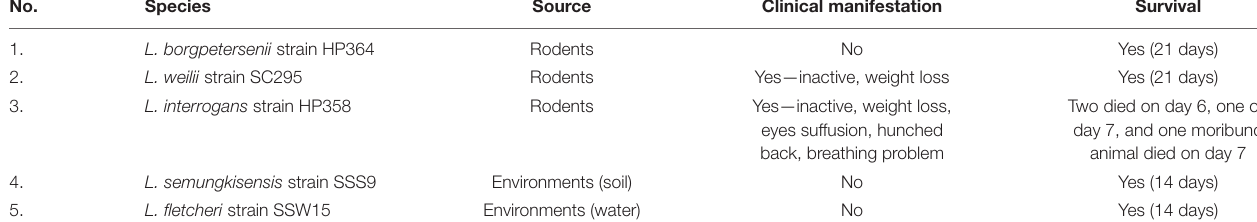
( Supplementary File 5, Table 1 ). Two (leptospiral endostation- like protein D and thermolysin) and one (leptospiral endostation- like protein D) virulence factors in L. borgpetersenii strain